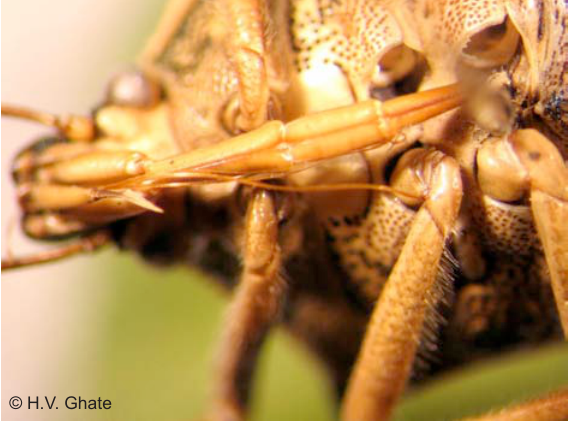
Image 5. Andrallus spinidens : ventral view of anterior region showing robust rostrum and hairy legs